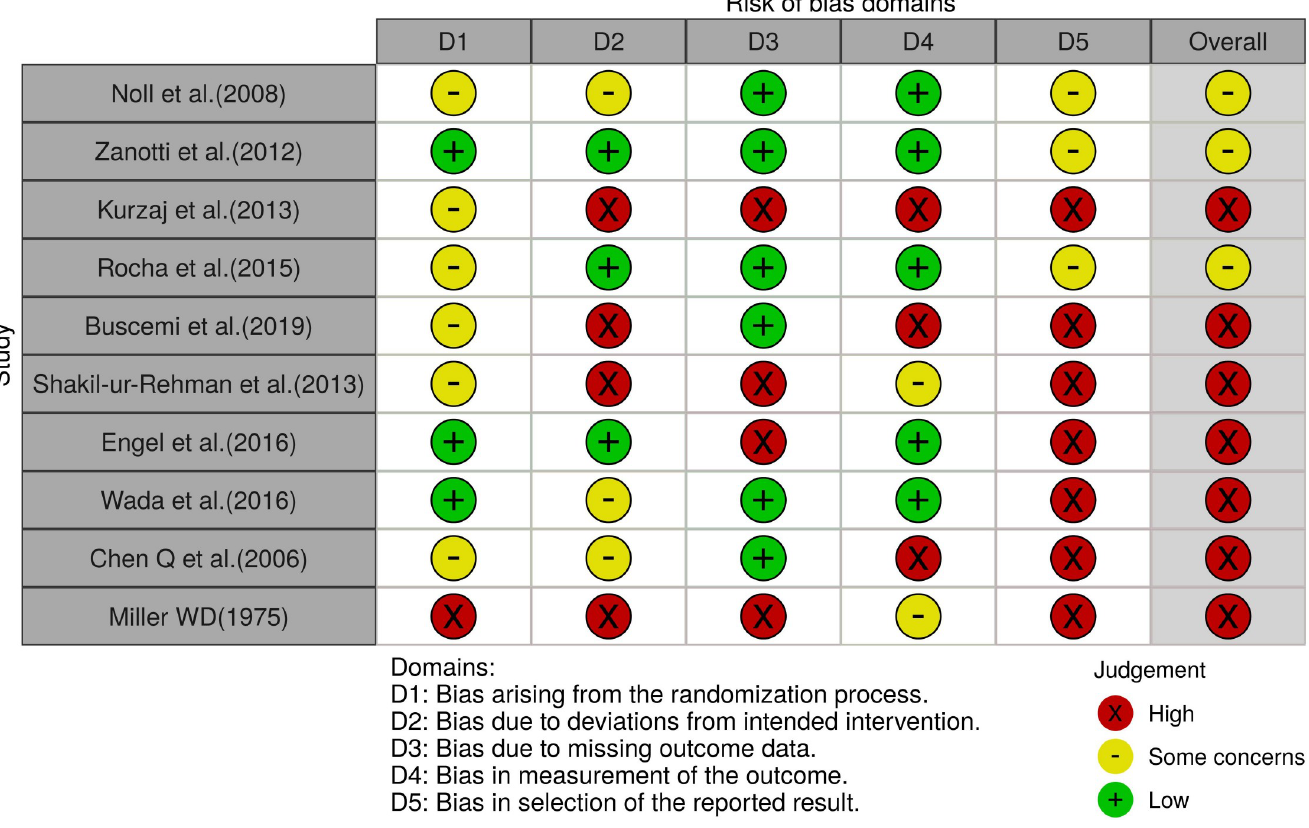
PLOS ONE | https://doi.org/10.1371/journal.pone.0251291 May 18,